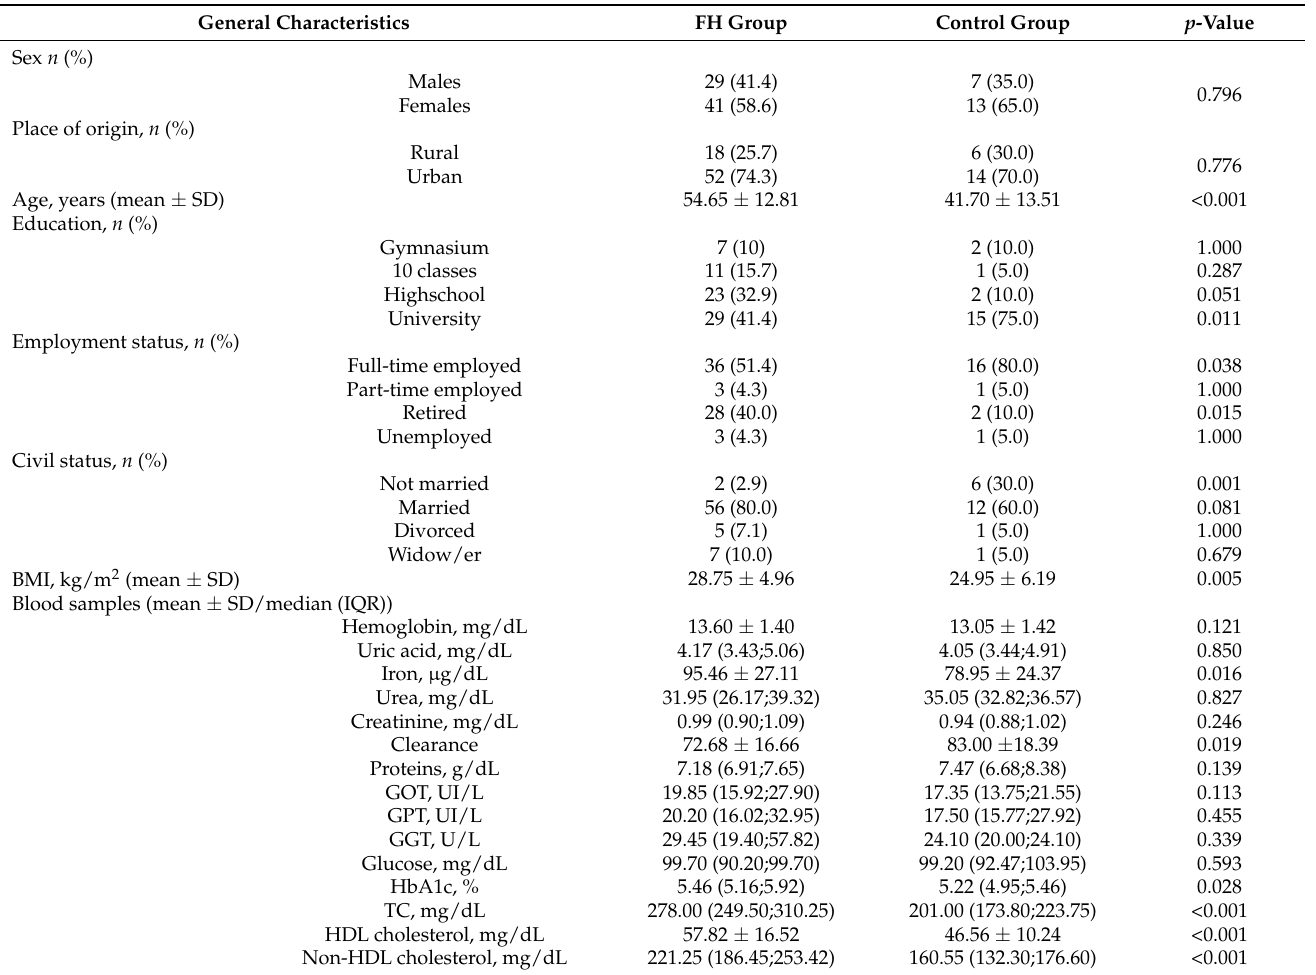
Table 1. General characteristics of the studied